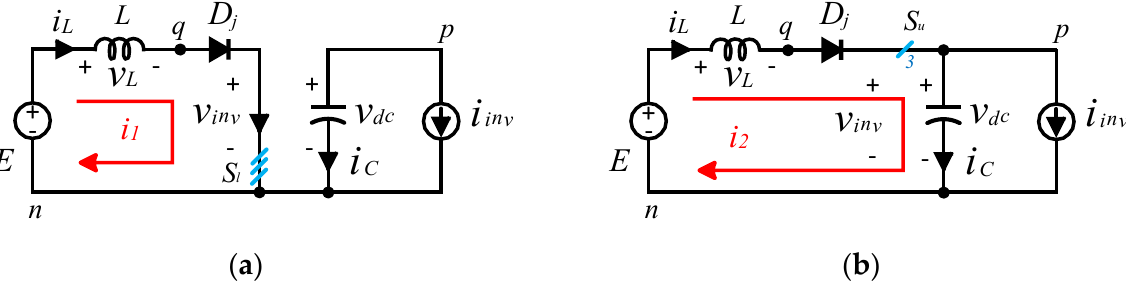
Figure 5. Mode of operation of three-phase SSI [14]. ( a ) Basic SSI topology (for states V 0 - V 6 ). ( b ) Inductive discharging (for state V 7 ).